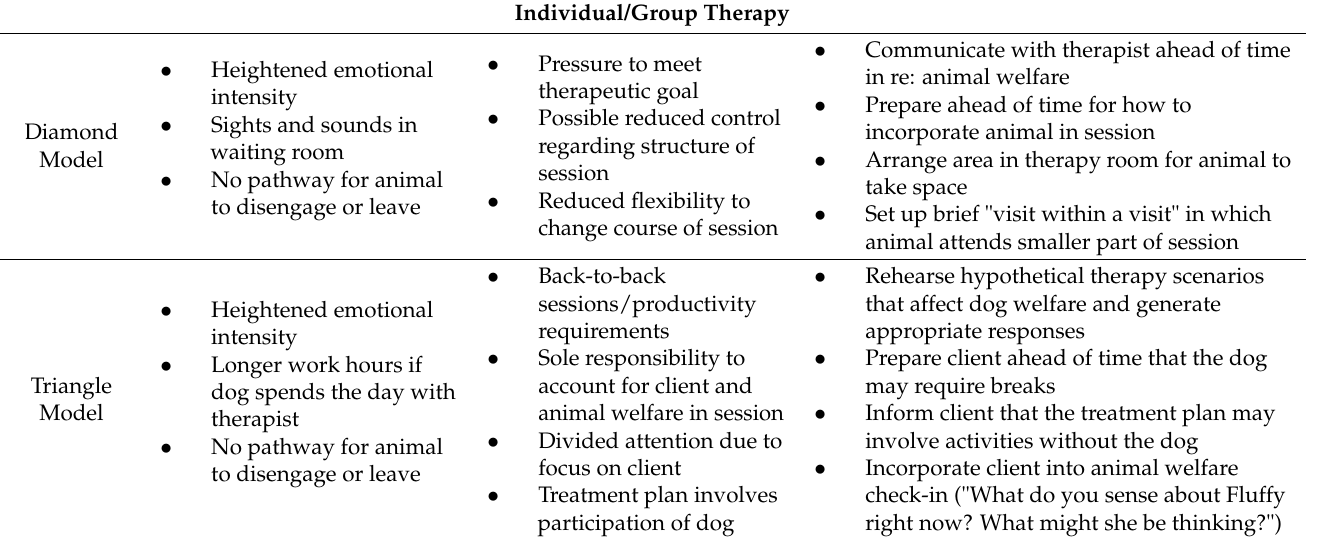
Table 3. Canine Stress Mitigation Strategies for Animal-assisted Therapy